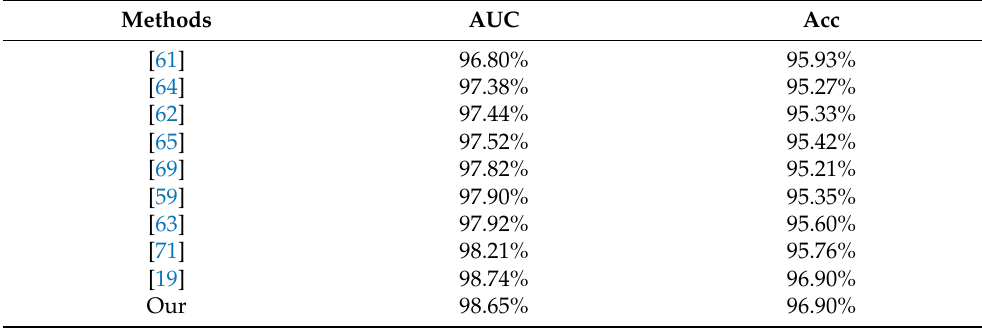
Table 8. A comparison with the state-of-the-art vessel segmentation methods on the DRIVE dataset.